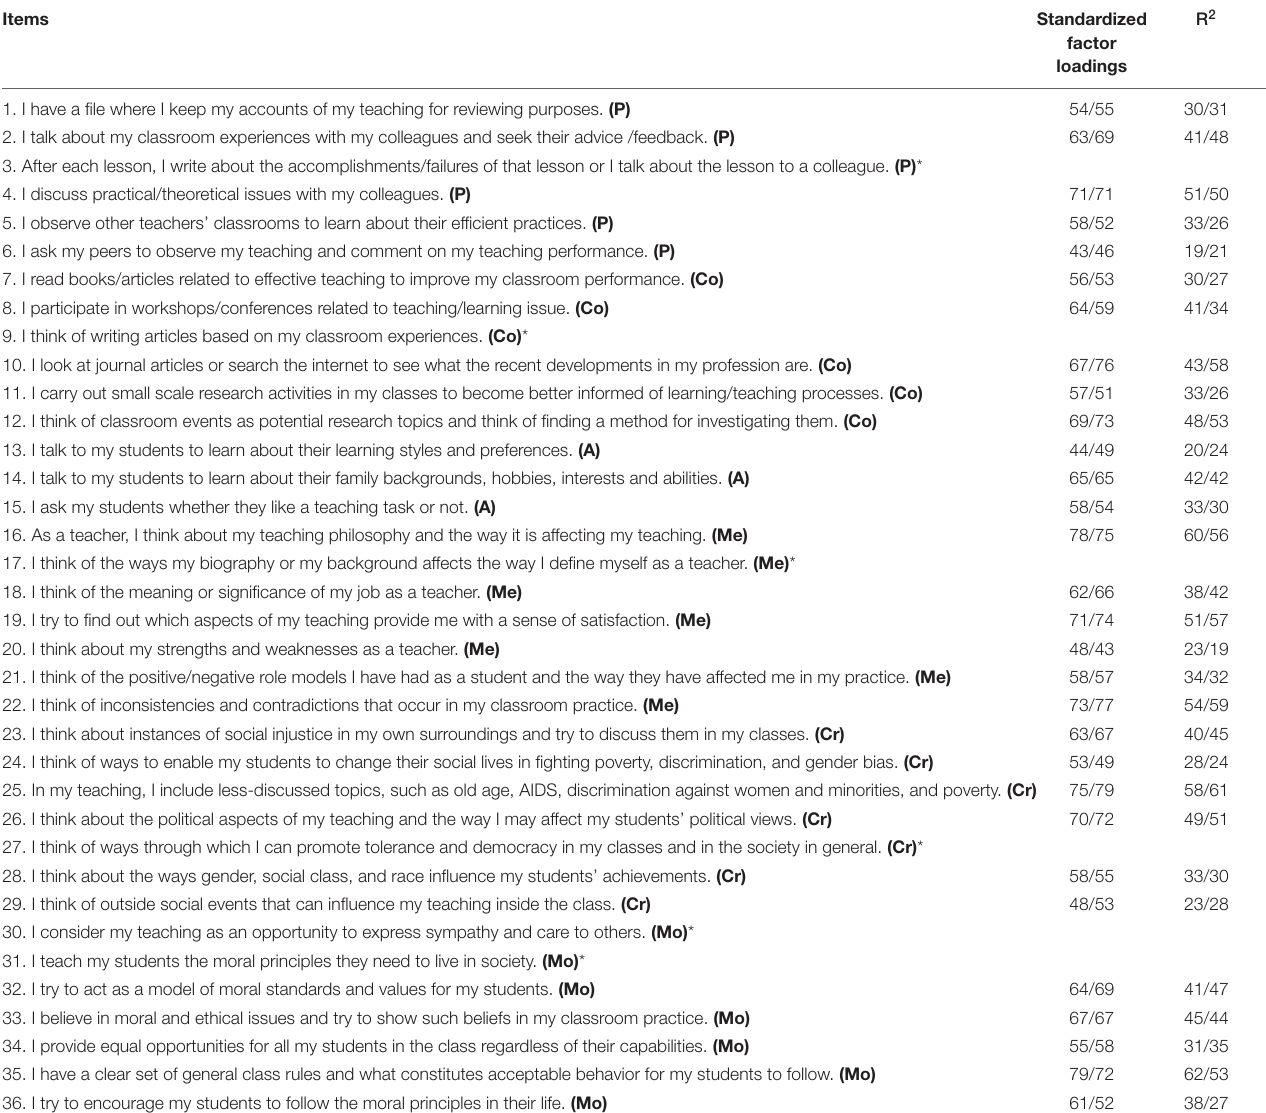
TABLE 2 | Adapted ELTRI items: standardized factor loadings of six-factor model (36 items) in sample 1 and sample 2.